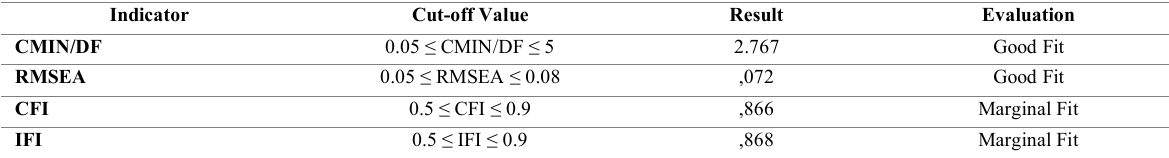
Table 5 : Goodness of Fit Result